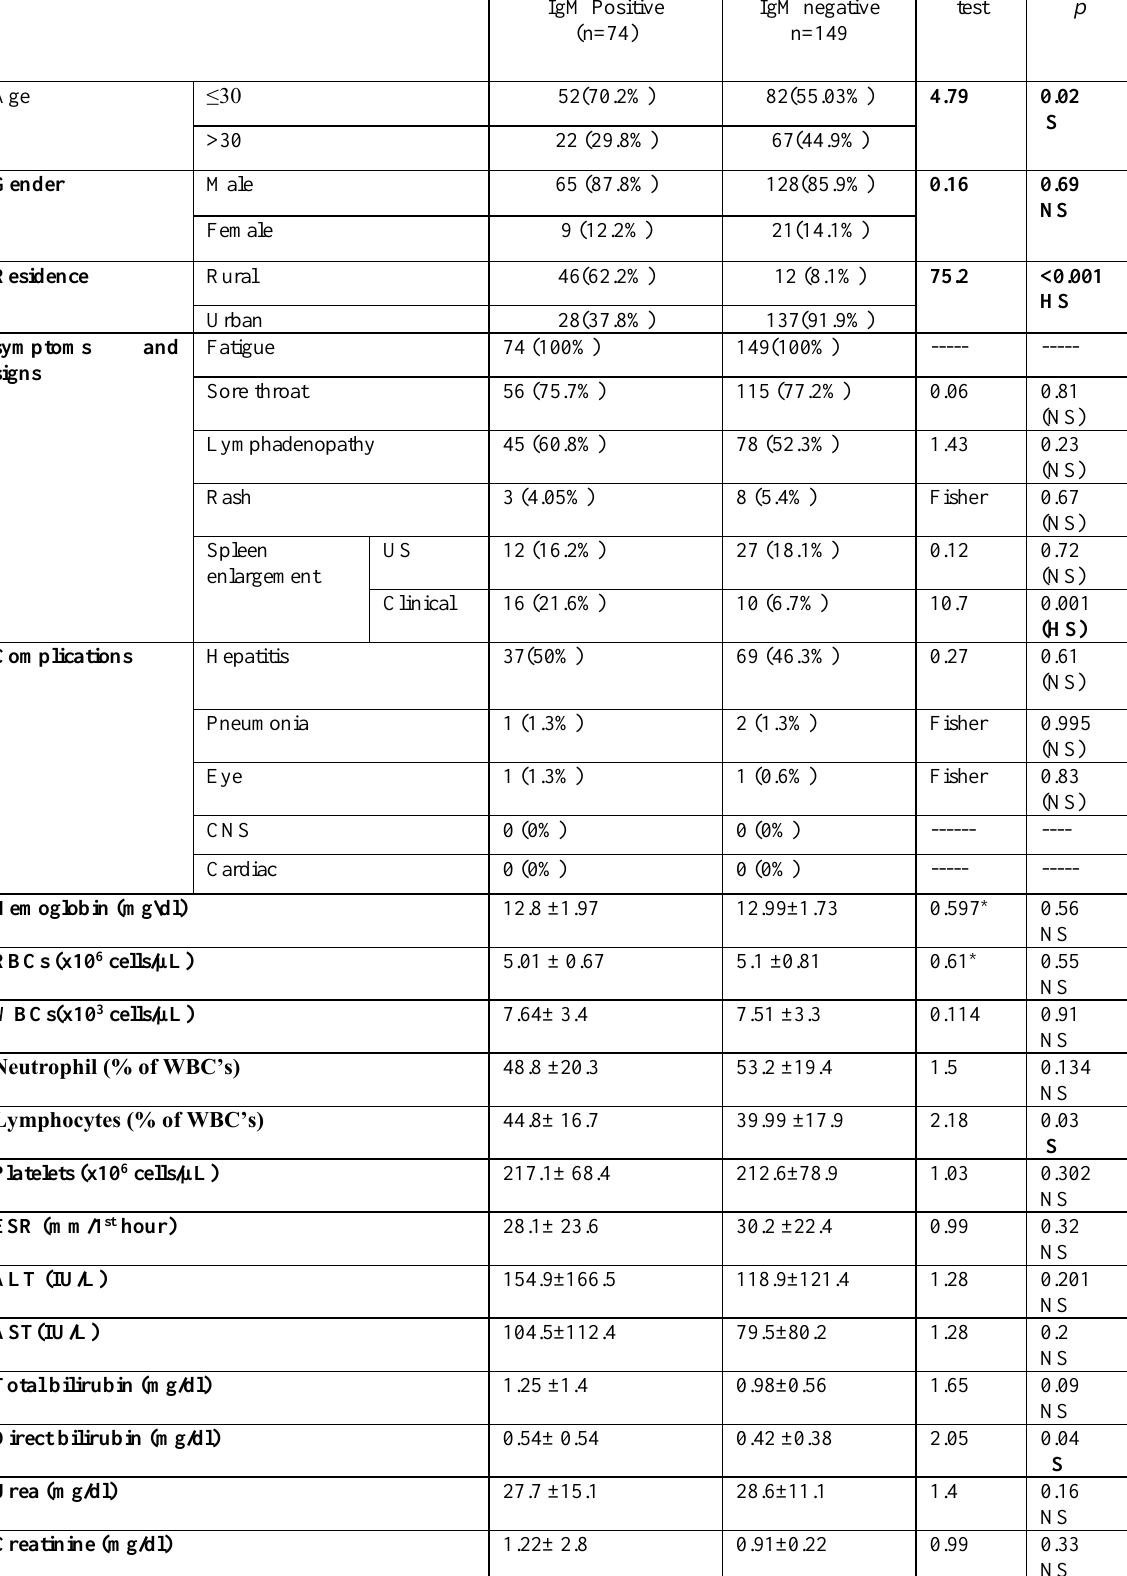
Table 3. Comparison between CMV patients and other patients as regards demographic, clinical and laboratory